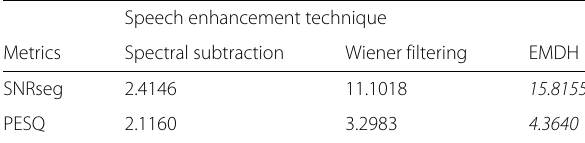
Table 1 Results of enhancement techniques using a sentence from dysarthric speaker JF extracted from the Nemours corpus Speech enhancement